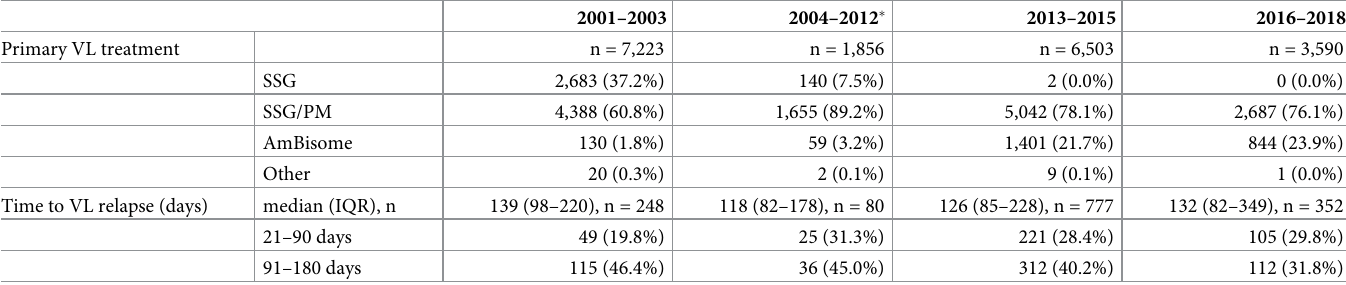
Table 3. Treatment of visceral leishmaniasis (VL) patients and time to relapse at Me´decins Sans Fronti è res (MSF) centres in South Sudan, 2001–2018 (from patient-level